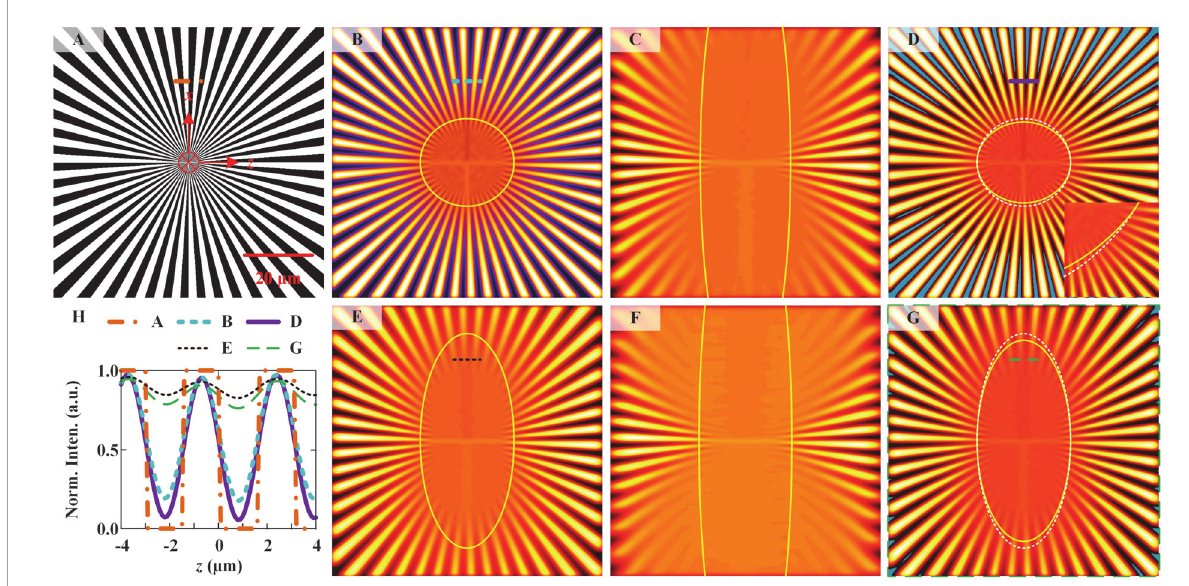
FIGURE3 Simulated imaging of a spoke-like sample by ILSM and NM-ILSM. (A) Spoke-like sample. ILSM image was acquired at the beam waist (B) and 20 µ m from the beam waist (C) . (D) NM-ILSM image was acquired at the beam waist. ILSM images were acquired at distances of 10 µ m (E) and 30 µ m (F) from the beam waist. (G) NM-ILSM image was acquired at a distance of 10 µ m from the beam waist. (H) Normalized intensity profiles along the correspondingly colored lines in (A–G)